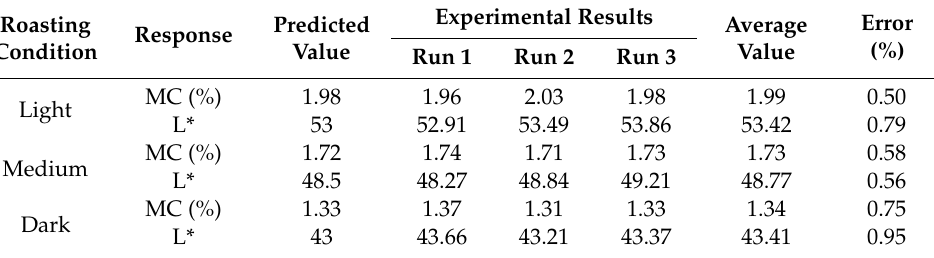
Table 5. Predicted and observed responses.